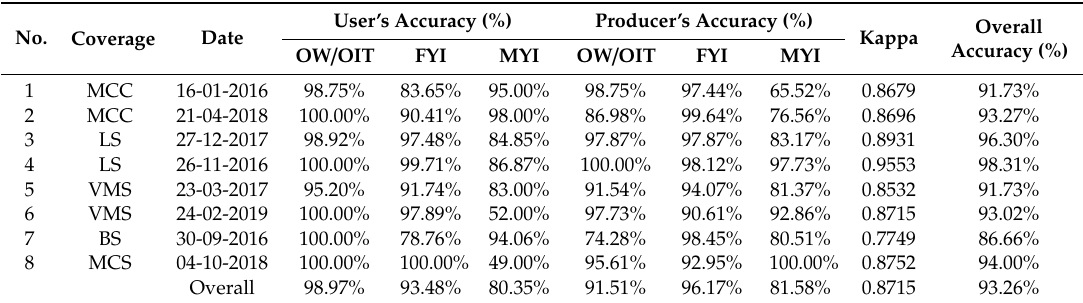
Table 4. Classification results from the TEMS-N